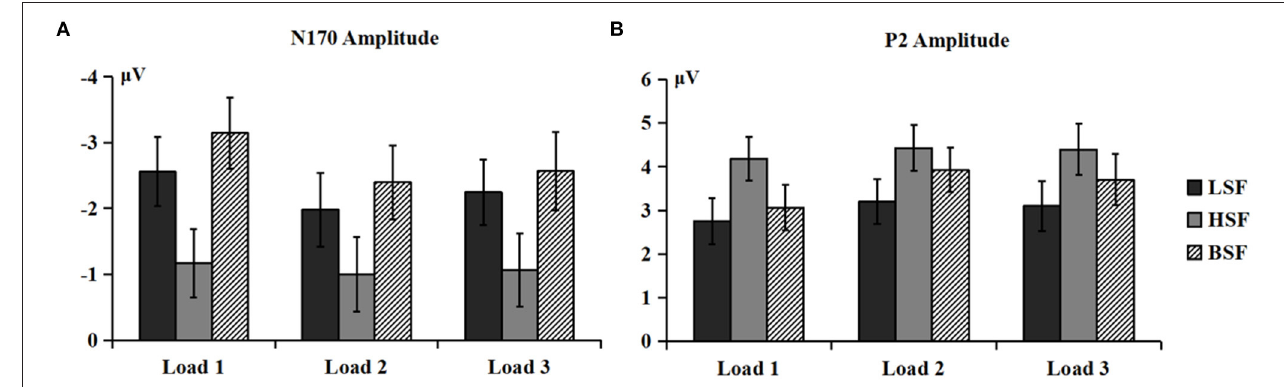
FIGURE 4 | Mean amplitudes of N170 (A) and P2 (B) components (P3/P4, P5/P6, P7/P8, PO3/PO4, PO5/PO6, PO7/PO8, and O1/O2) elicited by LSF, HSF, and BSF faces under different WM load